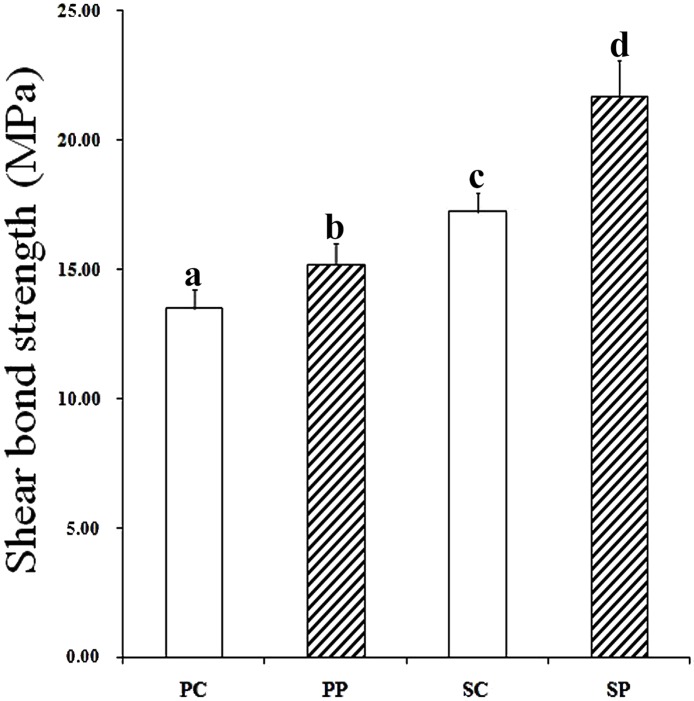
Shear bond strength of all groups.Different letters indicate a significant difference (P < 0.05).